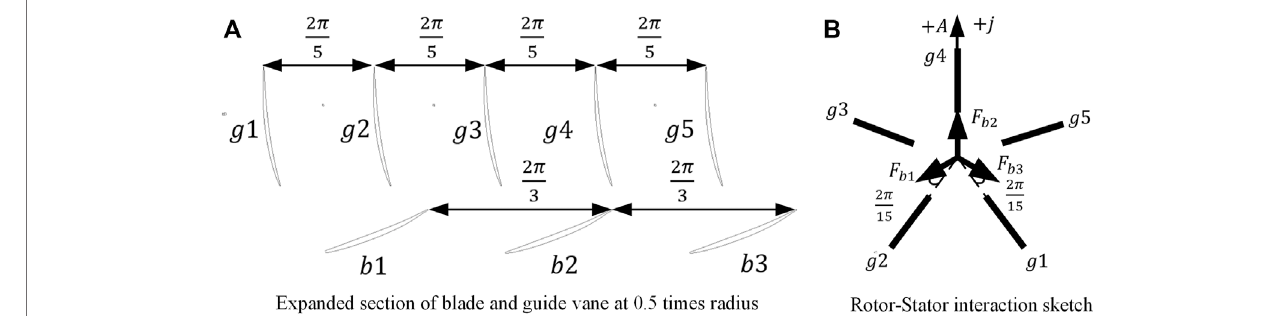
FIGURE 1 | Schematic diagram of rotor-stator expanded section and interaction sketch.